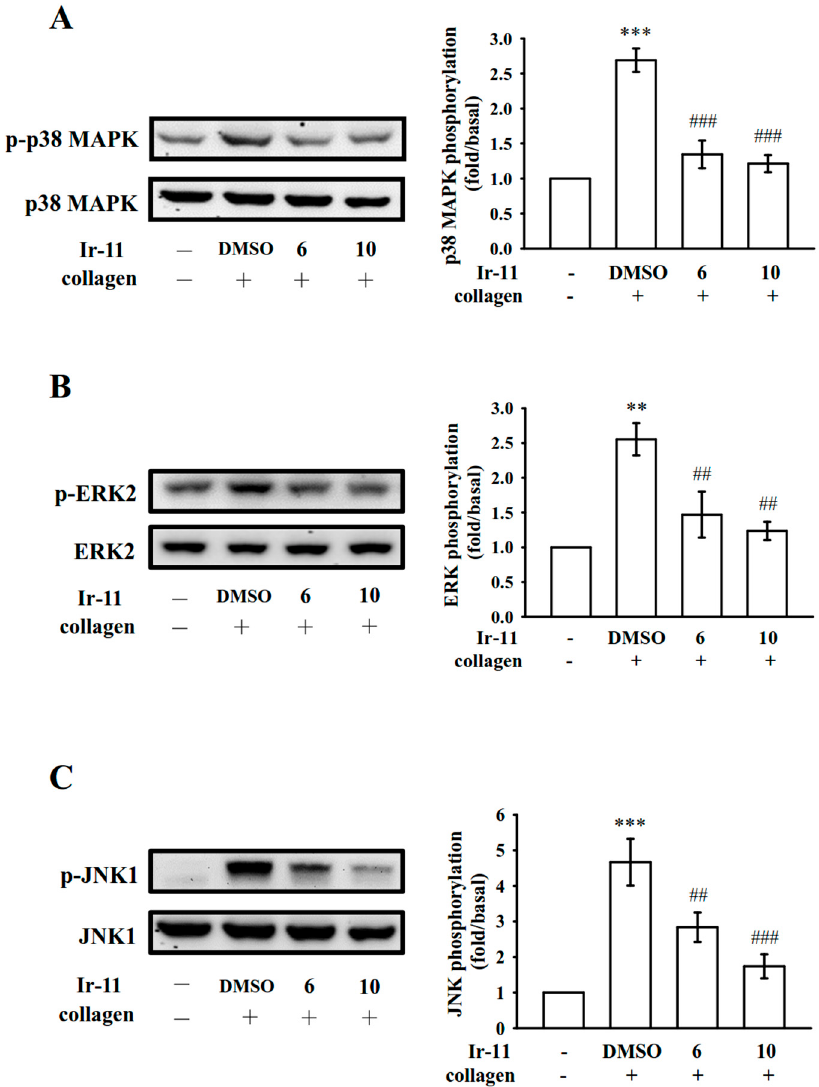
Figure 5. Effects of Ir-11 on p38 MAPK, ERK2, and JNK1 phosphorylation in collagen-activated platelets. Washed platelets were preincubated with the solvent control (0.1% DMSO) or Ir-11 (6 and 10 µ M) and subsequently treated with collagen (1 µ g/mL) to trigger ( A ) p38 MAPK; ( B ) ERK2; and ( C ) JNK1 activation. Platelets were collected, and their subcellular extracts were analyzed to determine the levels of protein phosphorylation. Data are presented as means ± standard error of the means ( n = 4). ** p < 0.01 and *** p < 0.001, compared with the resting control; ## p < 0.01 and ### p < 0.001, compared with the DMSO-treated group.